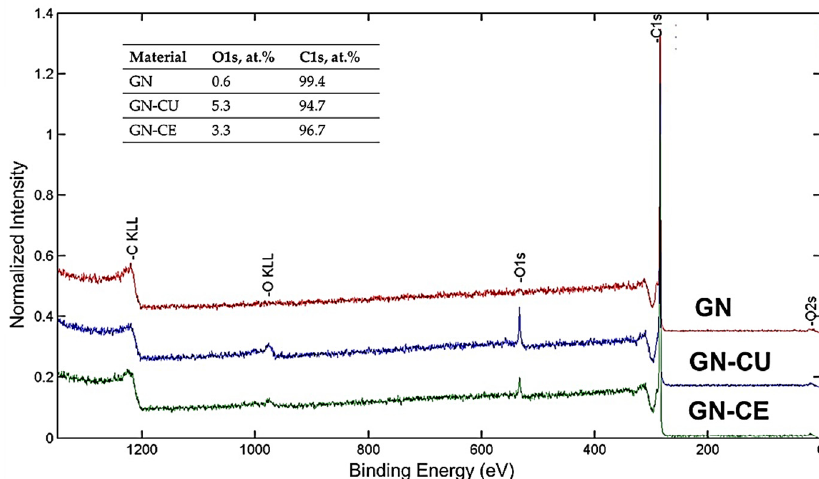
Figure 2. XPS spectra of the GN, GN–CU and GN–CE.